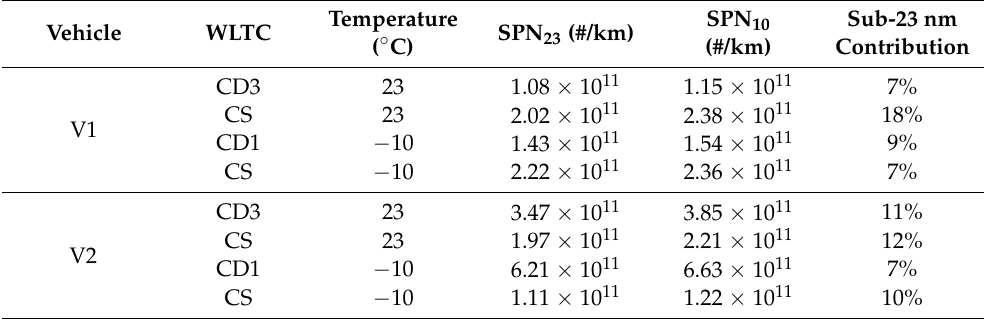
Table 4. Contribution of sub-23 nm particles, (SPN 10 -SPN 23 )/SPN 23 , at different laboratory cycles of V1 and